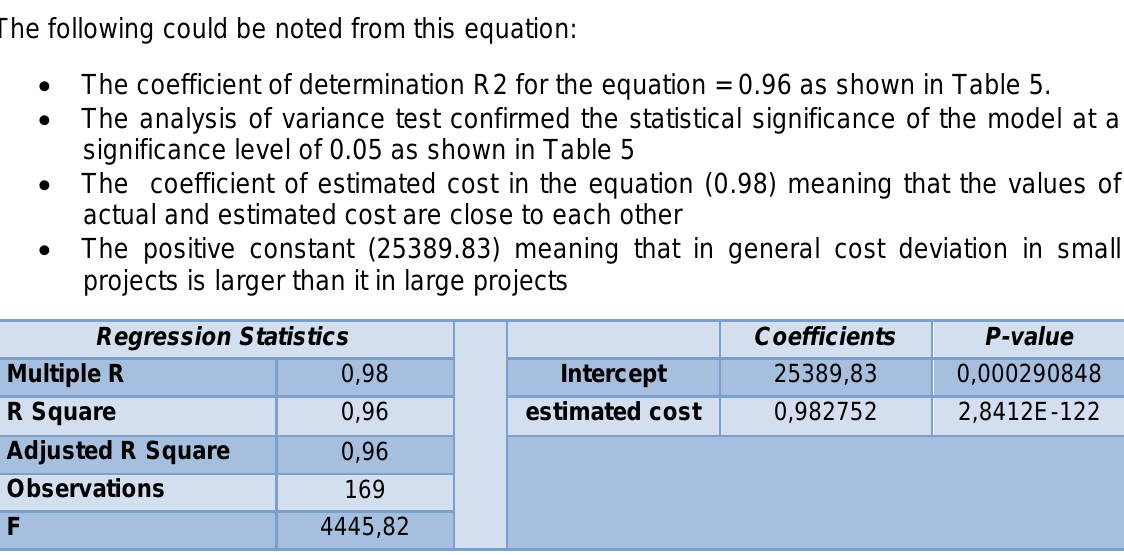
Table 5 Regression statistics of estimated cost vs. actual cost in road construction projects To establish that the relative cost deviation in small projects is larger than it in large projects, two regression models are developed; one describing the actual cost as a function of estimated cost for all projects except the large ones (i.e. projects with actual cost < $300000) and the other for projects of cost greater than $300000, the results are: